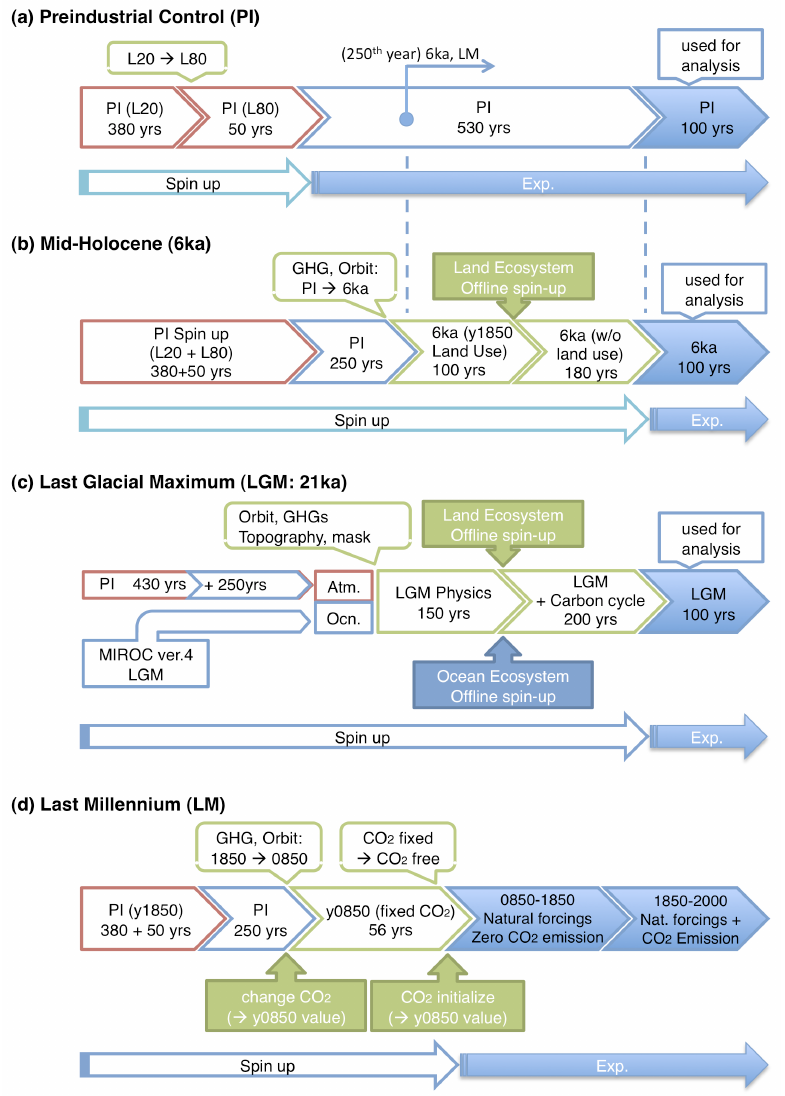
2 Fig. 3. The procedure of initial data preparation: (a) pre-industrial control: PI; (b) mid-Holocene: 6ka; (c) Last Glacial Maximum (LGM): 21ka; (d) Last Millennium: LM. Rounded rectangle denotes the change in boundary condition; shaded rectangle with arrow denotes the change in restart (initial) data, such as value overwriting and offline spin-up. For 6ka, the integration time from the point of initialization (i.e. “branch” time) was kept the same as PI experiments (dashed blue